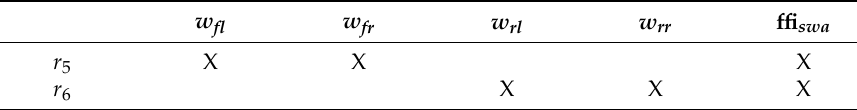
Table 2. Parameters semi-correlation table of steering wheel angle residuals.